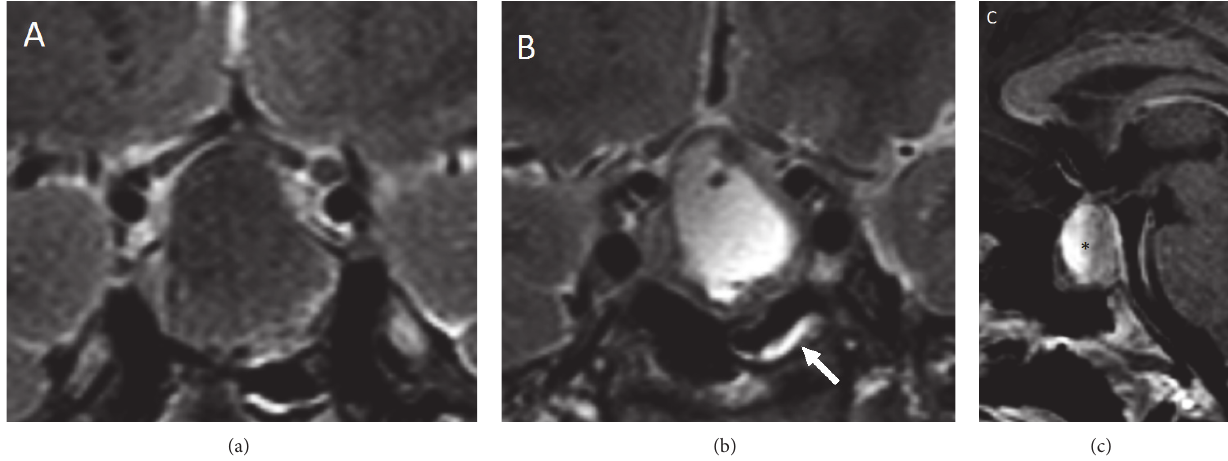
Figure 3: Coronal T2-weighted MRI images ((a) and (b)) and sagittal T1-weighted image (c) in patients with pituitary apoplexy showing (a) the low-signal haemorrhagic content of the pituitary mass, (b) the high-signal cystic area inside the lesion and the focal mucosal thickening of the sphenoid sinus (white arrow), and (c) a fluid-fluid intralesional level (asterisk) which is pathognomonic of pituitary